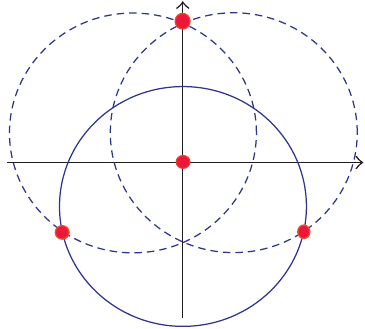
F 1: Four data points and three �tting